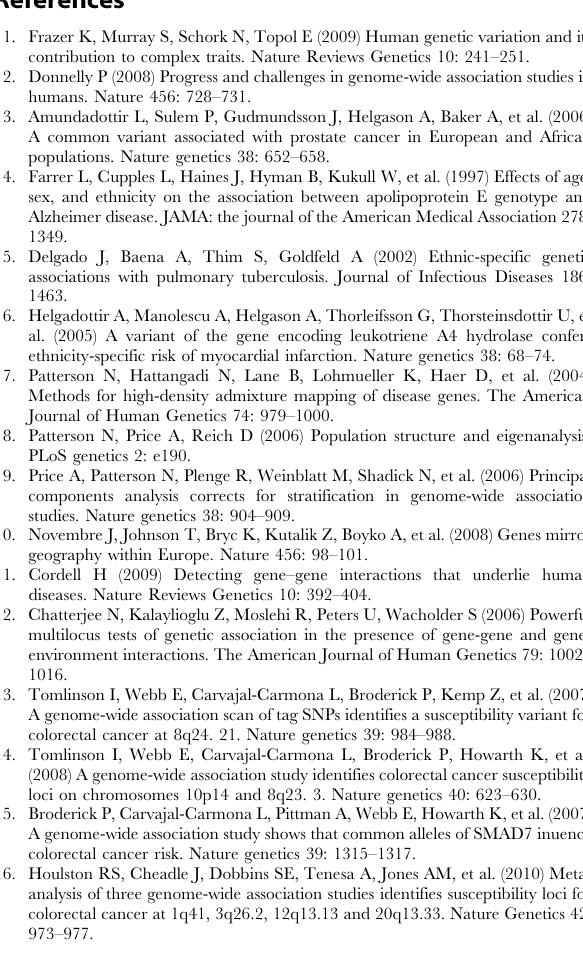
Table S6 Estimated power and p-values to detect an association at rs10455 in Phase 4 without principal component information as the switch rate varies. (PDF) Text S1 Description of Power Calculations for Replication Phases 3 and